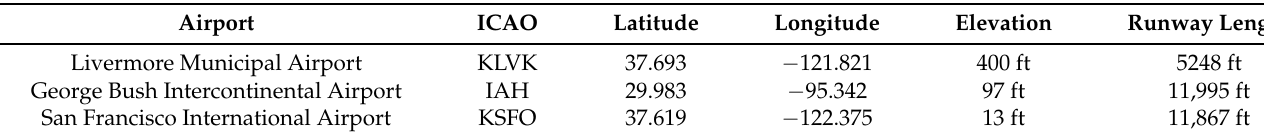
Figure 10. The first row is Data 1; the second row is Data 2; and the third row is Data 3. The first, second, and third columns show normal light, night visible, and infrared images, respectively. Table 2. Characteristics of three different